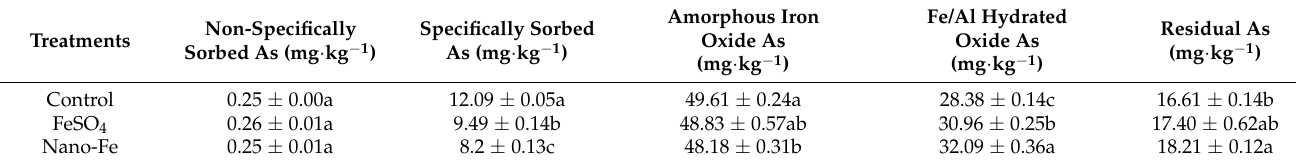
Table 3. Effect of exogenous Fe applied as FeSO 4 and Nano-Fe on As contents in soil.